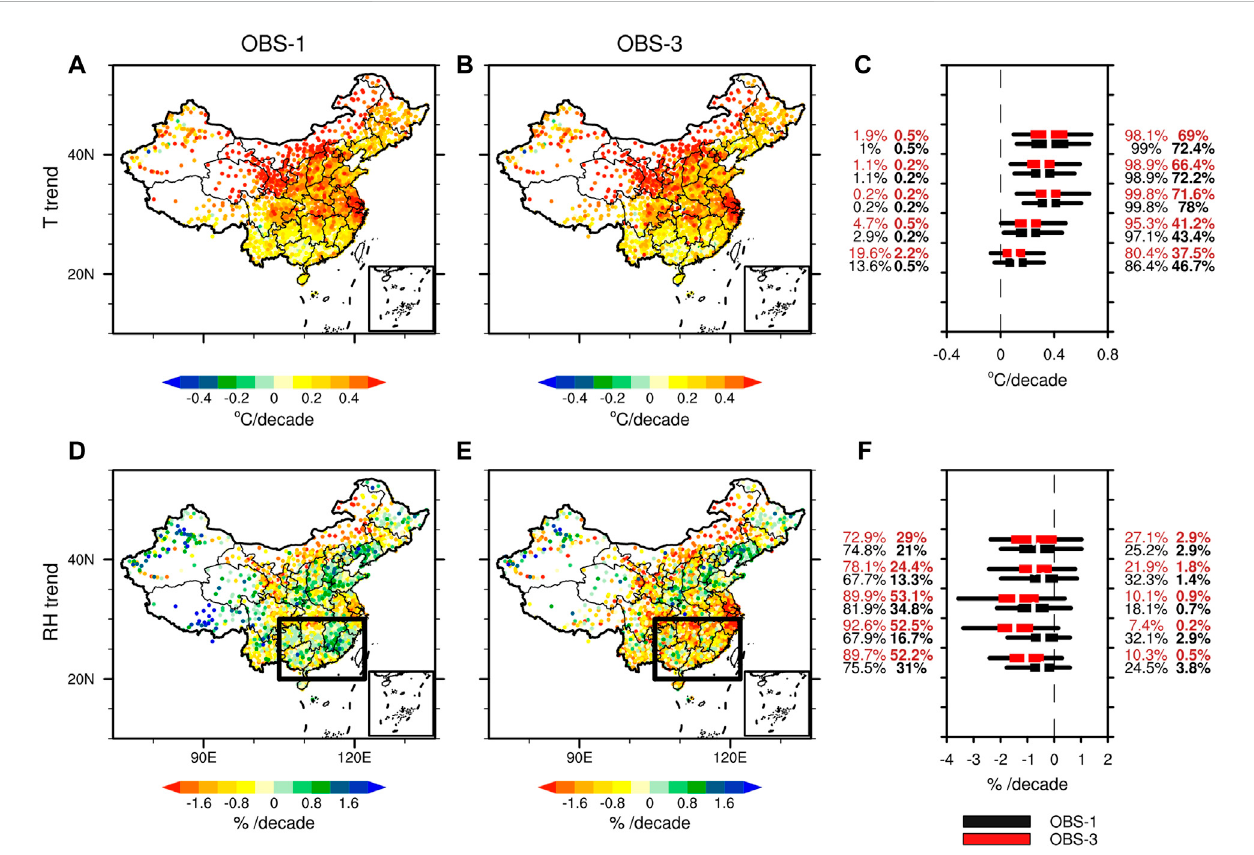
FIGURE 1 Trends for summertime Tand RH in China during 1979 – 2013. (A,B) show T trends ( ° C per decade) estimated by OBS-1 (homogenized) and OBS-3 (non- homogenized), respectively. The box-and-whisker plots shown in (C) presents the distribution of T trends amongst stations within each 5 ° latitudinal band, including the 5th, 25th, median, 75th, and 95th percentiles in OBS-1 (black) and OBS-3 (red). The numbers labeled to the negative/positive side of the x -axis indicatethefractionofstationsobservingnegative/positivetrendswithinthelatitudinalband,inwhichthefractionofstationregisteringsigni fi canttrends are bold-highlighted in the second column. (D – F) are the same as (A – C) but for RH.